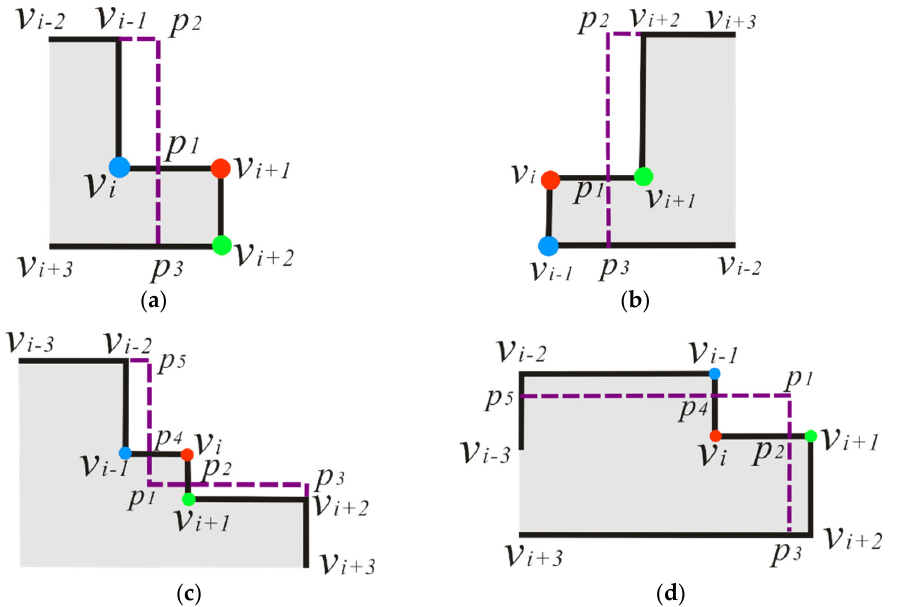
Figure 6. The simplification subtypes 5–8 and their operations. ( a ) Subtype 5, ( b ) subtype 6, ( c ) subtype 7, ( d ) subtype 8.